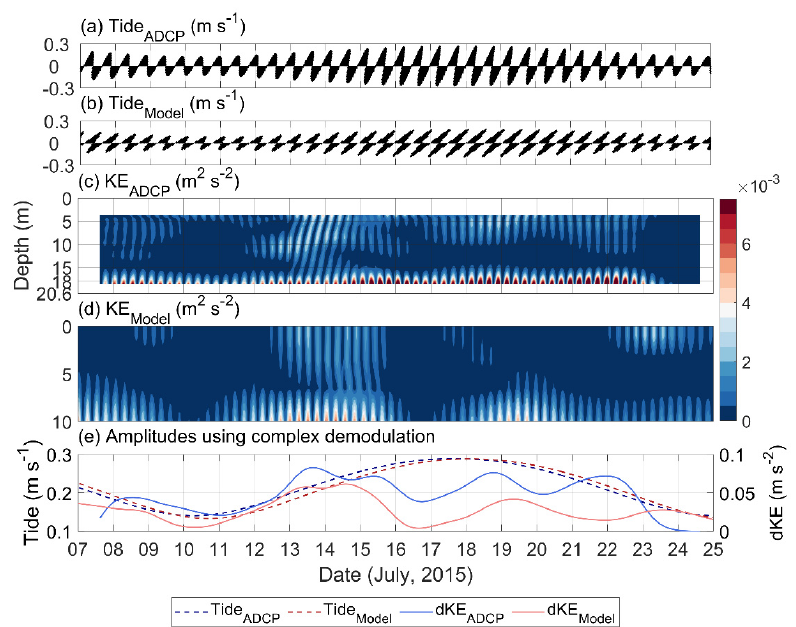
Figure 5. Timeseries of barotropic tide for M 2 and S 2 constituents from ( a ) the ADCP observation and ( b ) the outputs of DR_M; timeseries of kinetic energy for baroclinic semidiurnal currents from ( c ) the ADCP observation and ( d ) the outputs of DR_M. ( e ) Timeseries of amplitudes of barotropic tide for M 2 and S 2 constituents (dashed lines) and depth-integrated kinetic energy for baroclinic semidiurnal currents (solid lines) using complex demodulation from the ADCP observation (blue lines) and the outputs of DR_M (red lines).